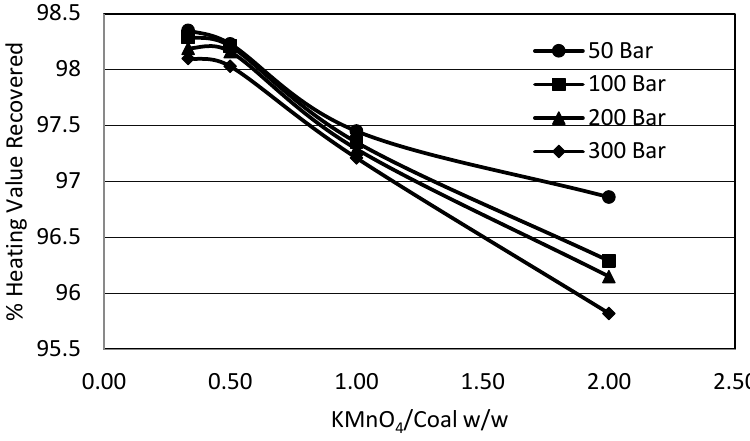
Figure 4. Effect of KMnO 4 /Coal ratio on heating value recovery.